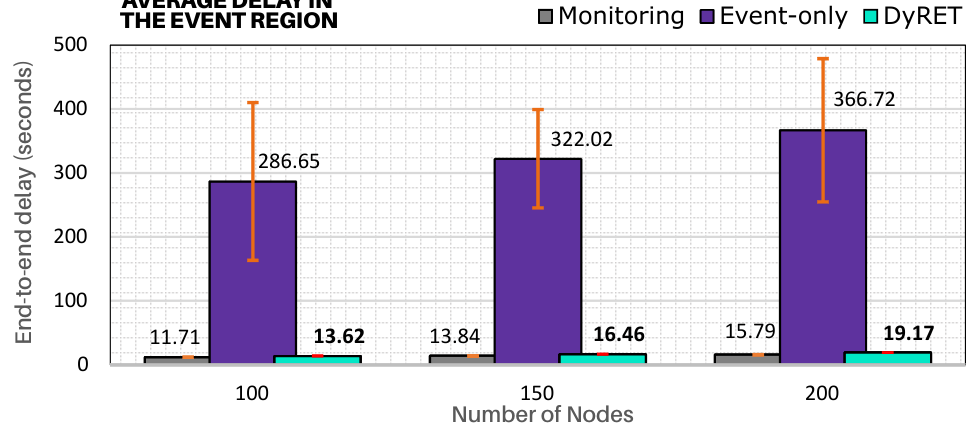
Figure 14. Average communication delay for sensor nodes involved in the critical event region.